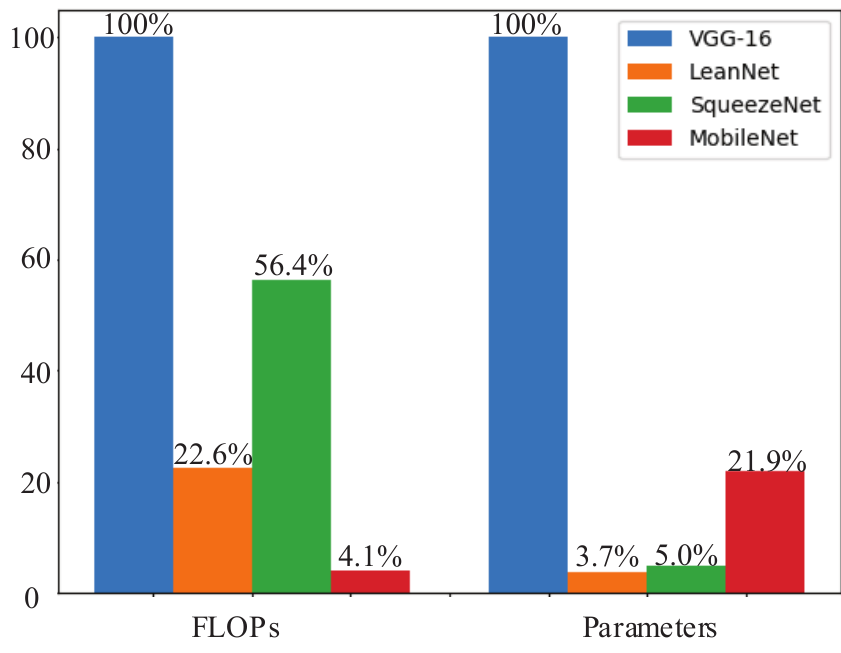
Figure 8. Comparison of parameters and computation under different